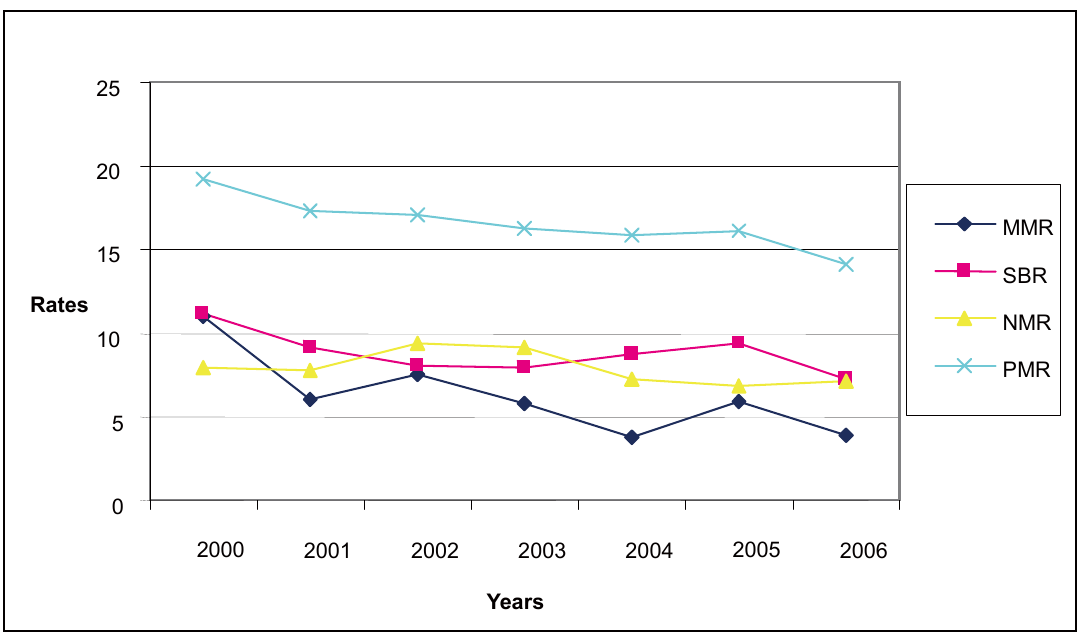
Figure 1. Service outcomes of